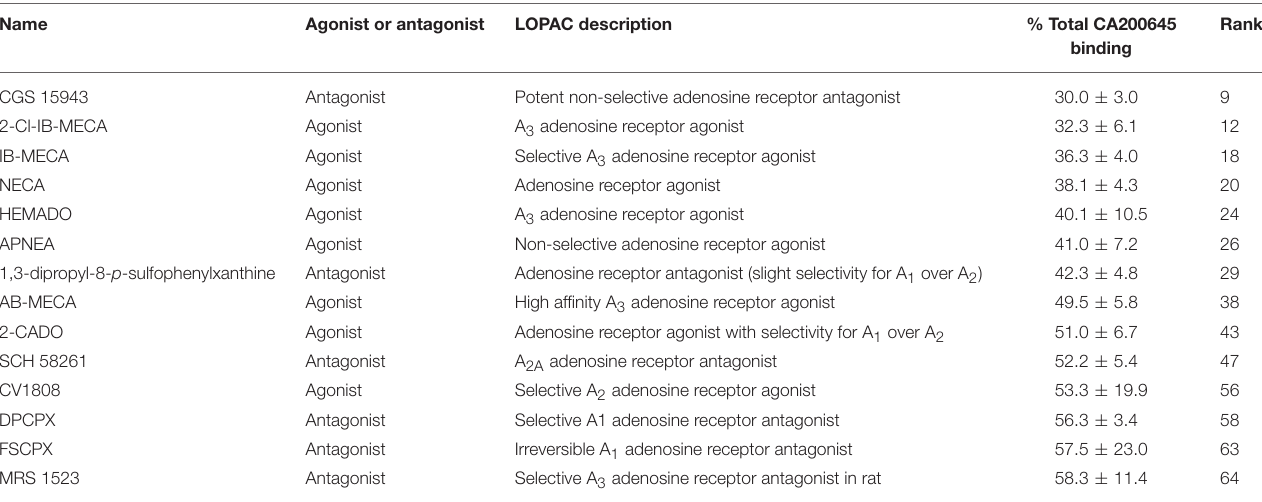
TABLE 3 | Known A 3 AR ligands in the LOPAC library: Compounds within the LOPAC library that have known activity at adenosine receptors, their rank order in the full screen and the % of 25nM CA200645 binding in the presence of 10 µ M of these